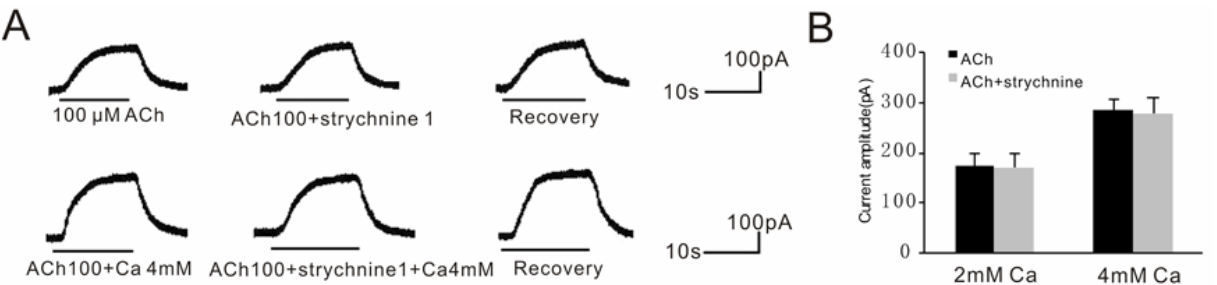
solutions. ( A ) BK Figure 6. Effect of strychnine on ACh response in different [Ca 2+ ] o currents evoked by 100 μM ACh were insensitive to 1 μM strychinine in both standard extracellular solution ([Ca 2+ ] = 2 mM) and 4 mM [Ca 2+ ] solution. These currents were o o obtained from the same VHC II at −50 mV; ( B ) A bar histogram shows the percentage of blocking effect of 1 μM strychnine on the BK current evoked by 100 μM ACh in standard extracellular solution or 4 mM solution. Each point is the mean ± SD of 5